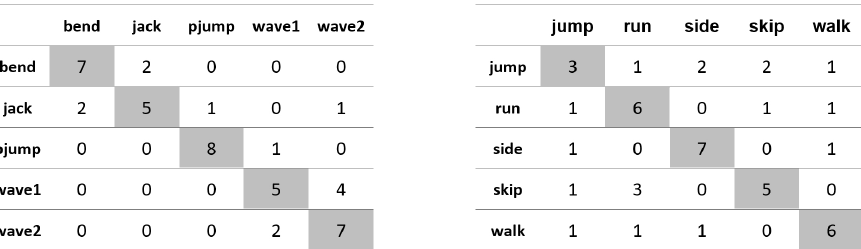
Figure A30. Confusion matrices for the experiment using the ‘upper-occlusion’ database, eccentricity and C1 correlation.